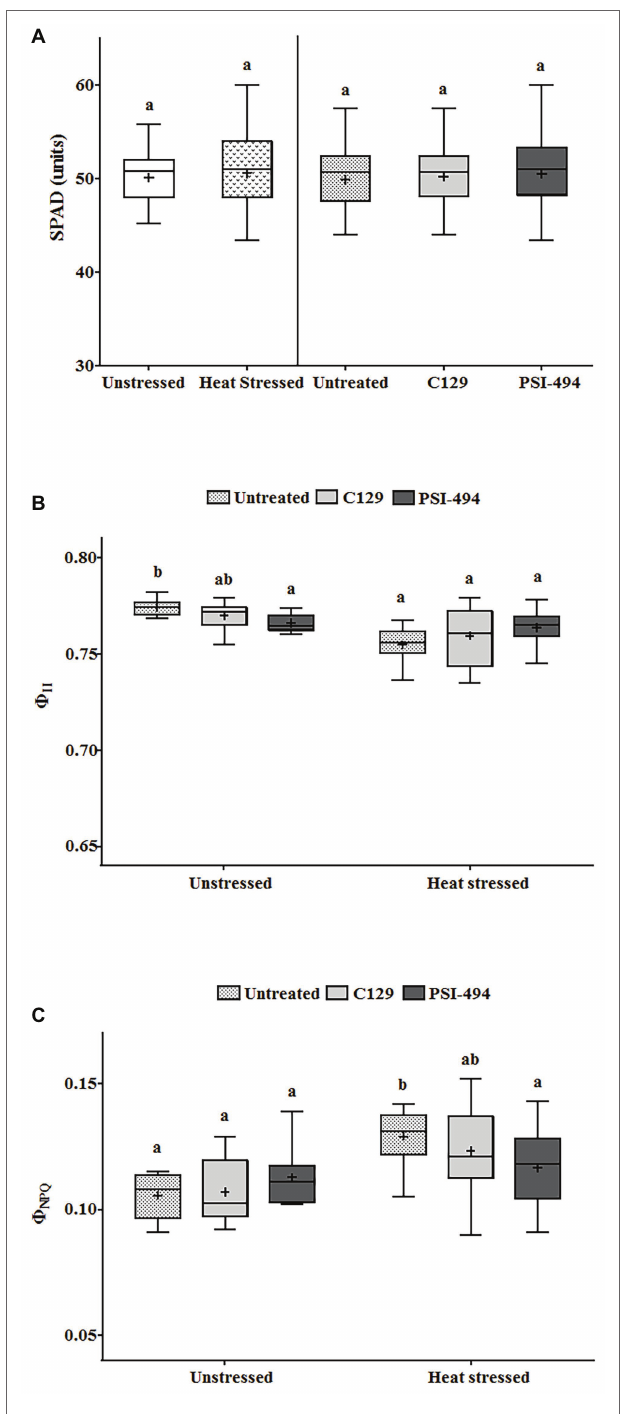
FIGURE 4 | Effect of heat stress and ANEs on photosynthetic parameters of tomato plants. (A) PQ-SPAD; (B) Φ II ; and (C) Φ NPQ . Data were measured in 122-day-old plants and subjected to two-way ANOVA and Tukey’s HSD test for evaluating the differences among means at p ≤ 0.05. Since there was no significant AxB interaction for PQ-SPAD, the effect of condition and ANE treatment was evaluated separately, statistical differences for p ≤ 0.05 based on t -test (condition) or one-way